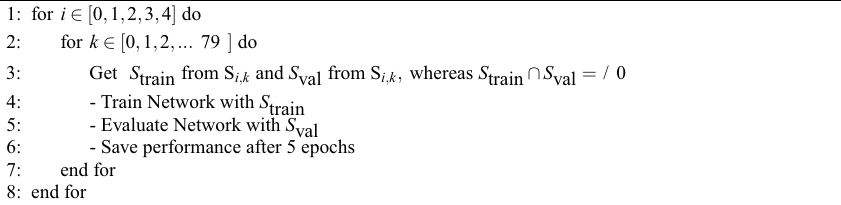
Algorithm 1: Pseudo-code for successively investigating the network’s performance based